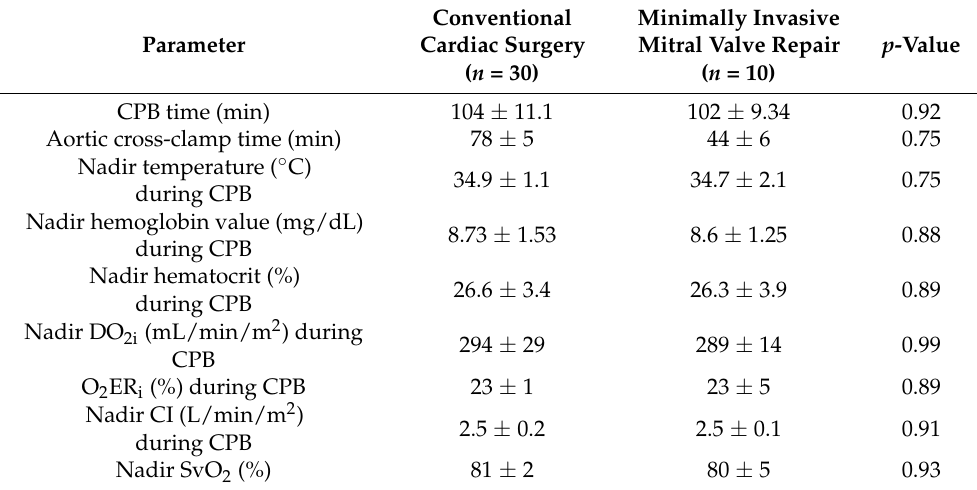
Table 2. Operative data.